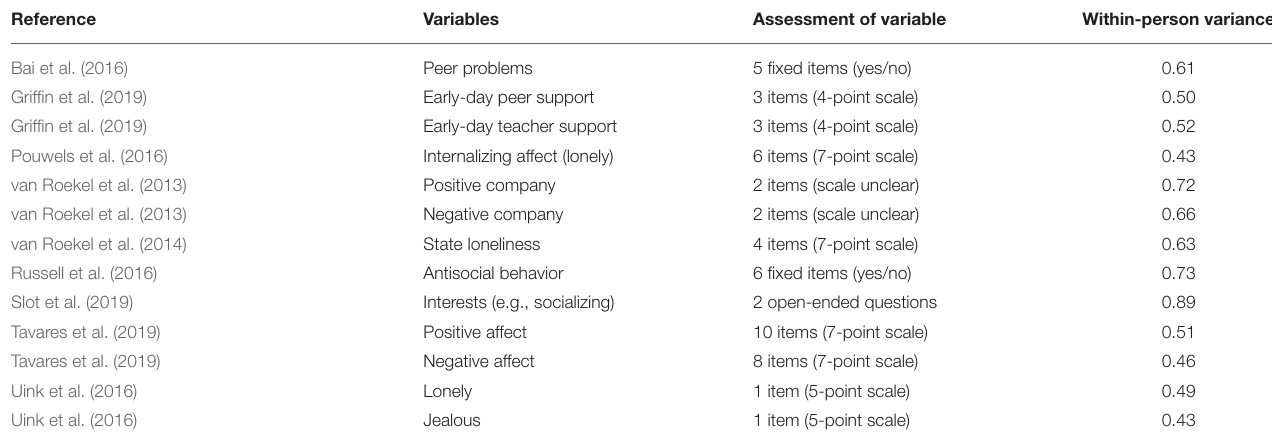
TABLE 3 | Proportion of variance at the within-person level of social interaction